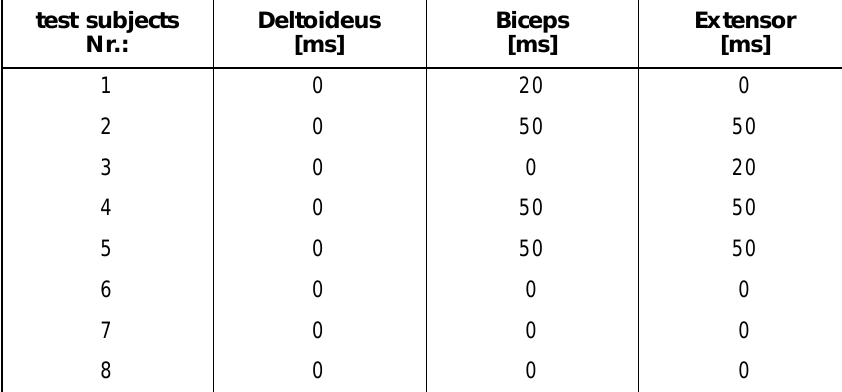
Table 7: Innervation sequences in abduction of healthy